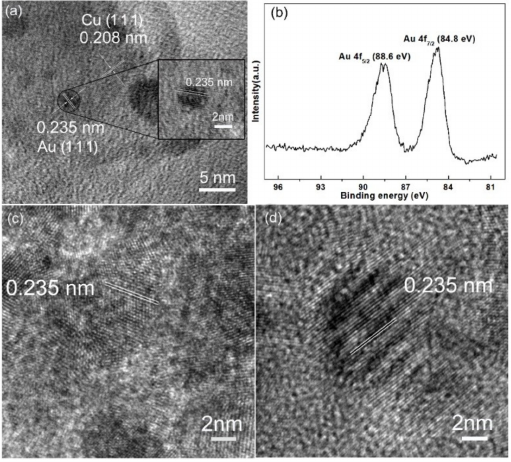
Figure 3. ( a ) High-resolution transmission electron microscopy (HRTEM) and ( b ) High-resolution XPS spectrum of Au 4f of Au@Cu nanoarrays with galvanic reaction time of 3 min. ( c , d ) are HRTEM images of Au@Cu nanoarrays with galvanic reaction time of 1 min and 5